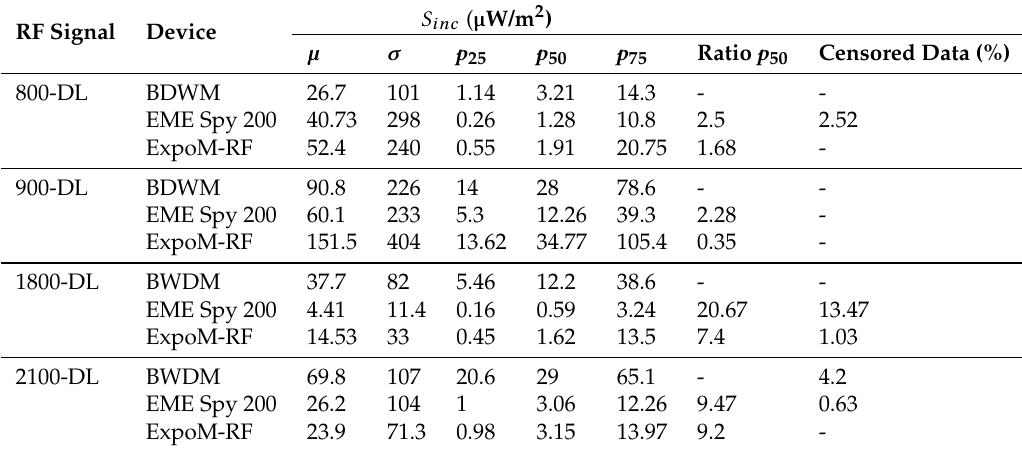
Table 7. Summary statistics of four downlink bands measured during the walk for the BWDM and two conventional